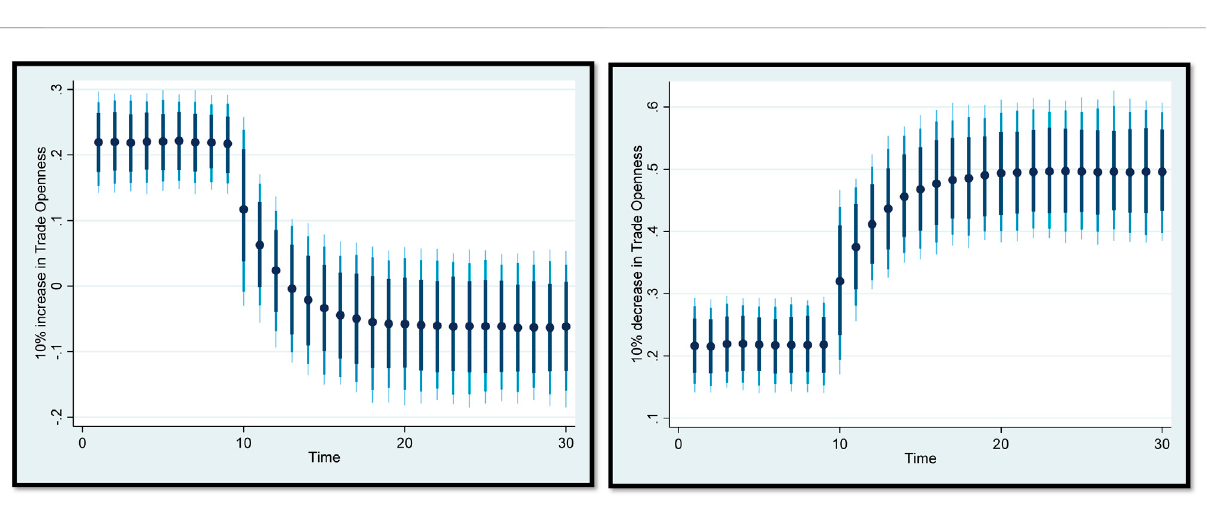
FIGURE 7 Impulse response plot for trade openness and CO 2 emissions. An increase and a decrease of 10% in trade openness and its effect on CO 2 emissions, where dots denote the average prediction value. The dark blue to light blue lines show 75%, 90%, and 95% con fi dence intervals, respectively.